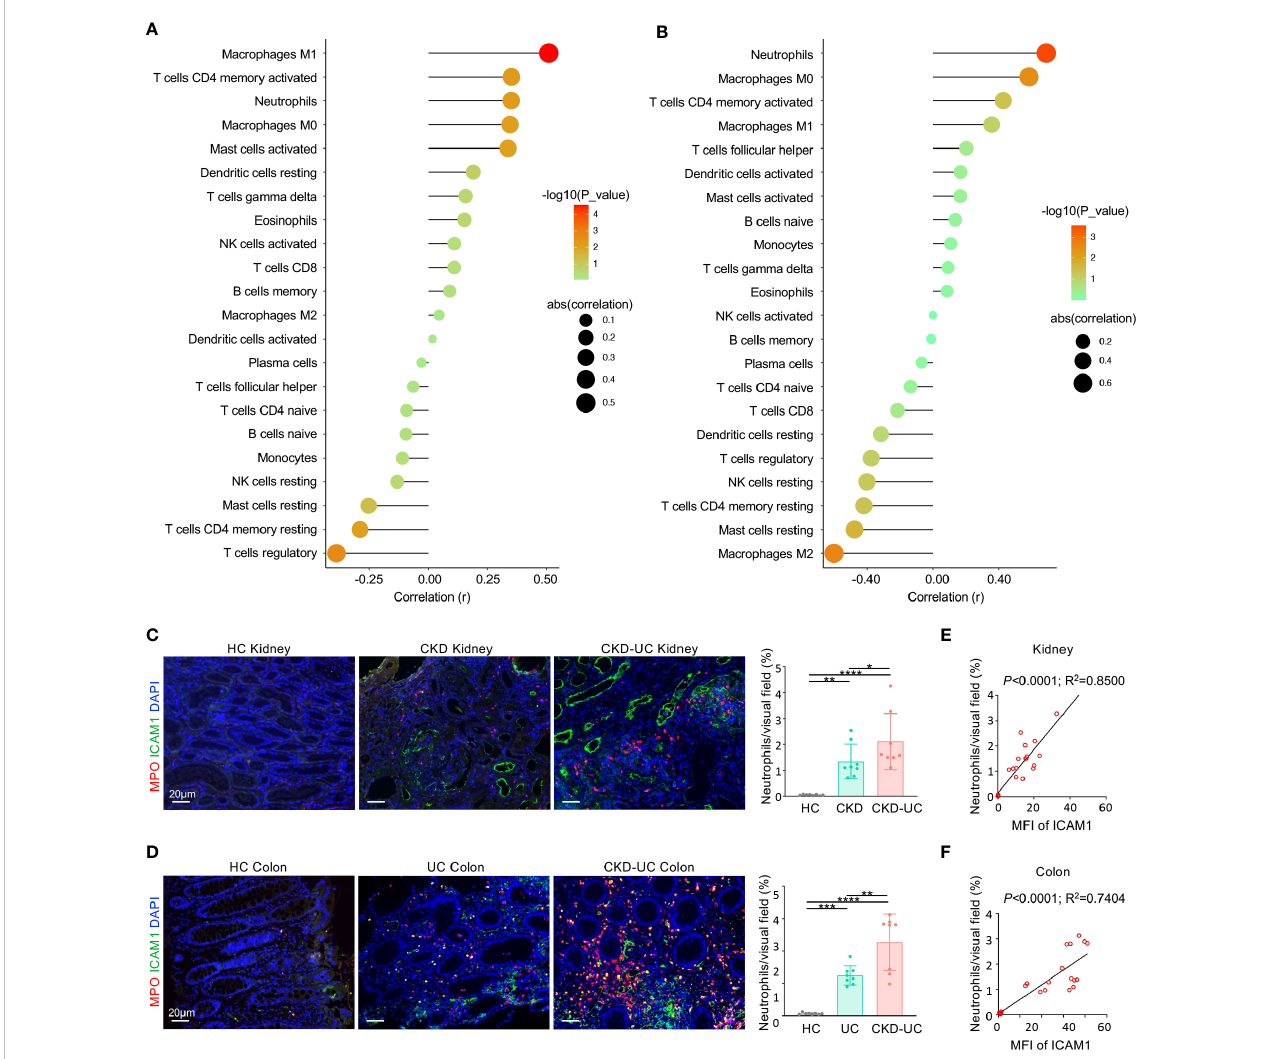
FIGURE 7 Correlation of hub gene and immune cell in fi ltration in CKD and UC. (A, B) Correlation of ICAM1 expression level and immune cell subtypes in GSE 66494 of CKD (A) and GSE4183 of UC (B) . (C, D) Representative immuno fl uorescence images of ICAM1 (green) and neutrophil marker MPO (red) of renal (C) and colon (D) biopsies from HC, CKD, UC, CKD-UC patients. Cell nuclei were counterstained with DAPI (blue). Scale bars, 20 m m. The MFI of ICAM1 was measured by Image J. The quantitative analysis on the percentage of neutrophils per visual fi eld was performed using Image J. (E, F) The MFI of ICAM1 was measured by Image J. The relationship between MFI of ICAM1 and neutrophils in renal (E) and colon (F) biopsies was analyzed with Pearson ’ s correlation analysis. HC, healthy control; CKD, chronic kidney disease; UC, ulcerative colitis; MPO, myeloperoxidase; MFI, mean fl uorescence intensity. Data in C and D were presented as mean ± SEM, ****P < 0.0001; ***P < 0.0005; **P < 0.005; *P < 0.05;